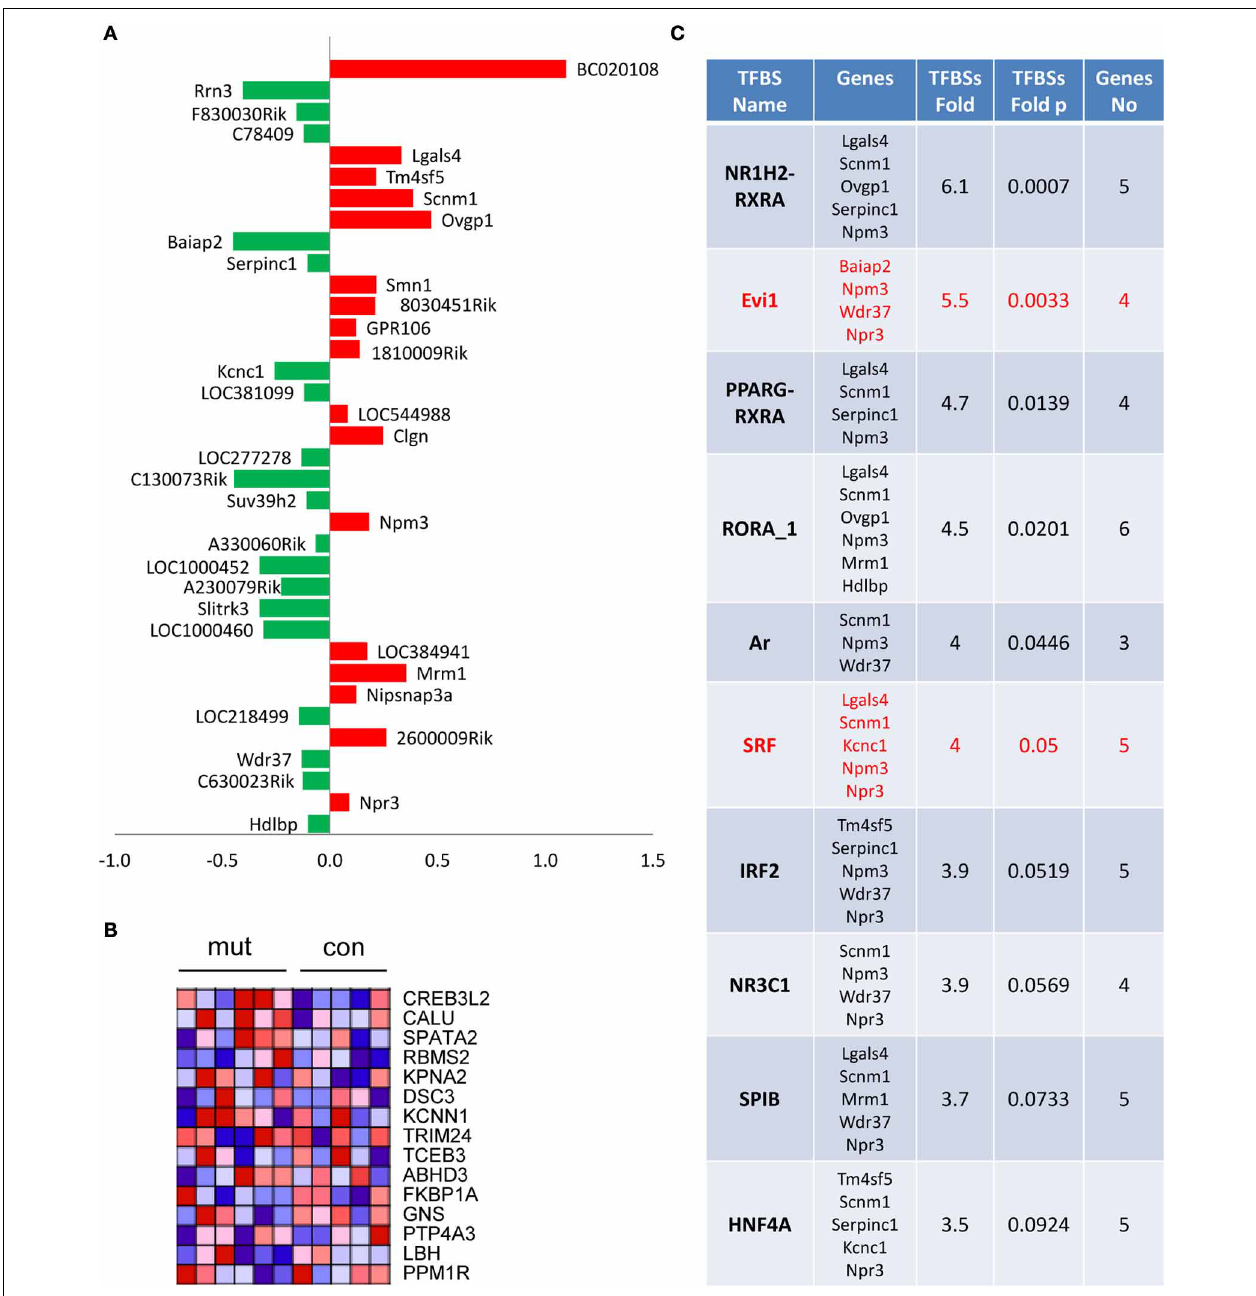
FIGURE 8 | Moderate effects on gene expression in TIF-IA CaMKCreERT2 mutant mice. One month after tamoxifen treatment. (A) Identification of 36 transcripts at unadjusted p < 0 . 001 and their fold change vs. control group; (B) Heat map